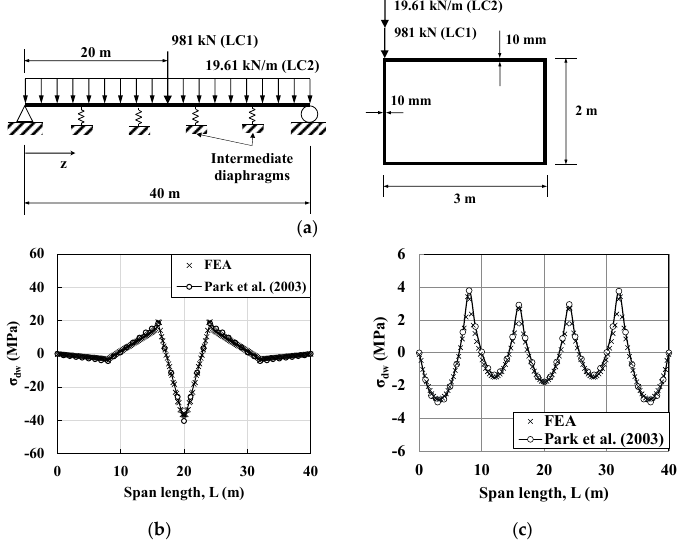
Figure 4. Comparison of the FEA and literature [9]. ( a ) Load and boundary conditions of the FEA model, ( b ) comparison of the FEA results and literature under a concentrated load case (LC1), and ( c ) comparison of the FEA results and literature under a distributed load case (LC2). To achieve convergency of the FEA results, the fine mesh size, which is sixteen ele- ment numbers along the flange, was used based on the sensitivity analysis. The same mesh sizes along both longitudinal directions of the girders and vertical direction (web line) were used. The sensitivity analysis results are presented in Figure 5.